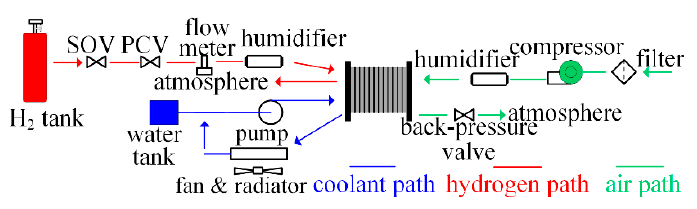
Figure 1. Schematic of a proton exchange membrane fuel cell (PEMFC) system.